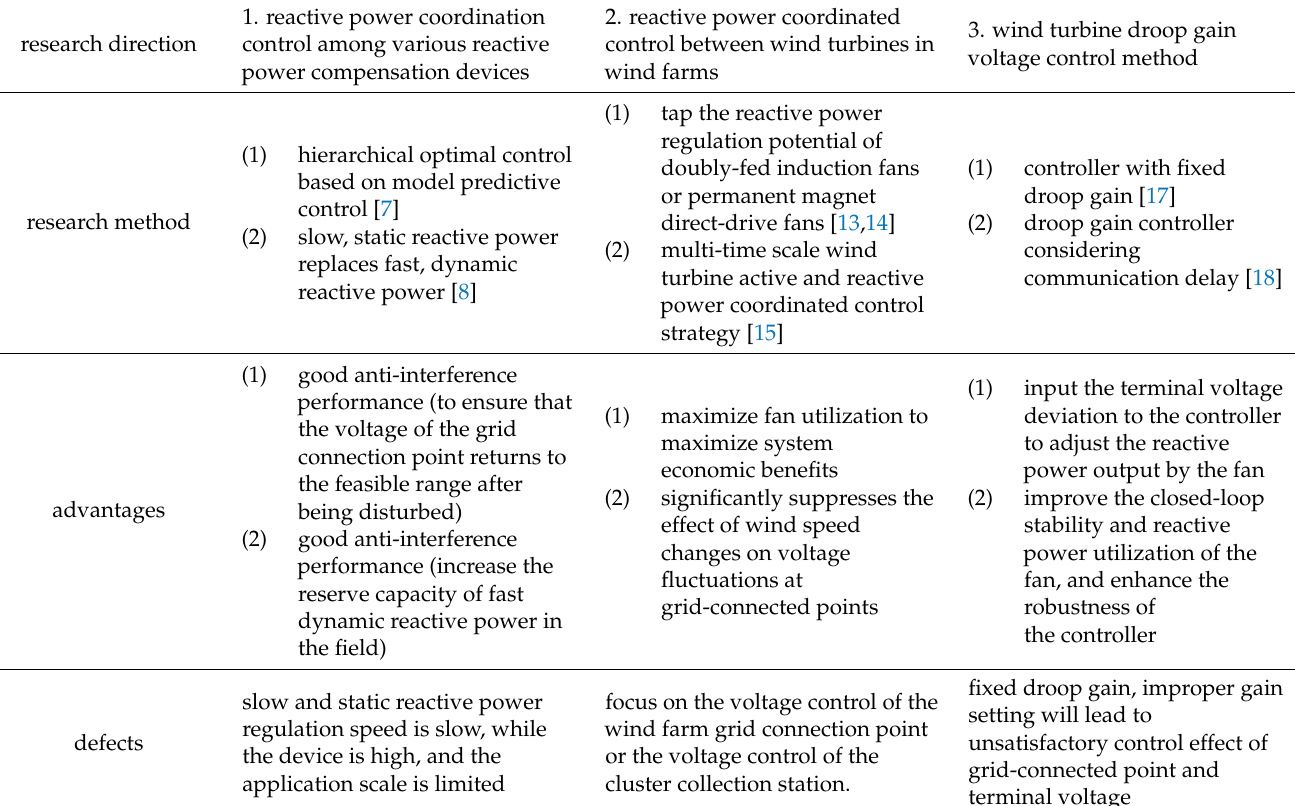
Table 1. Previous papers’ proposed reactive